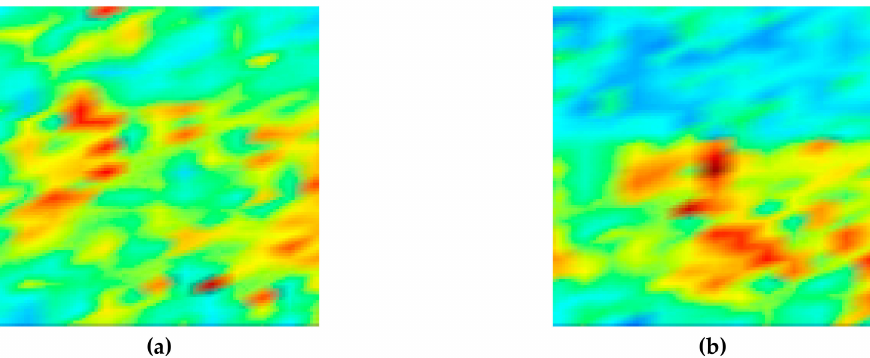
Figure 23. Ultrasonic images of a dissimilar-metal weldment specimen with a notch using ( a ) a 45 ◦